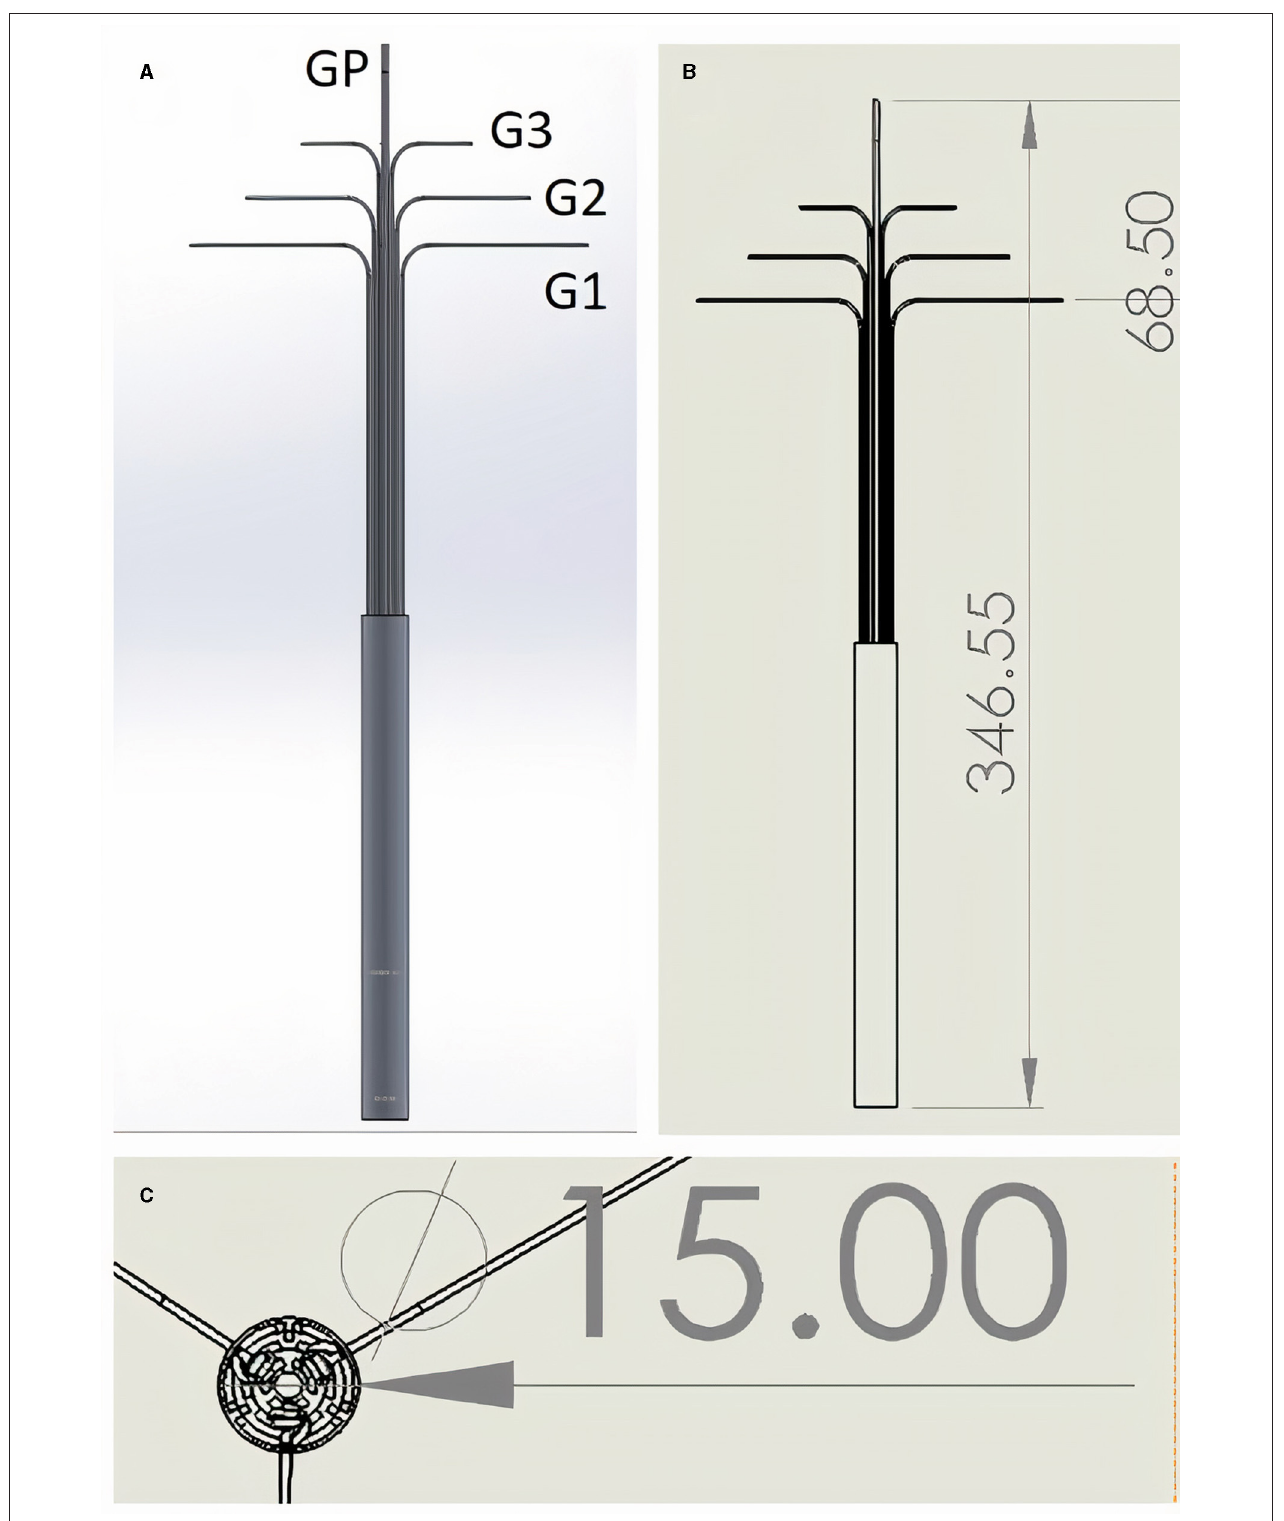
FIGURE 1 | (A,B) Lateral view. One single Grip (GP) controls forward protrusion and backwards retraction of the instrument. Grips G1–G3 are triplicate (only two of each are visible in the 2D lateral view images shown), and control each of the three distal arms to which they are attached (distal arms not visible - infolded and covered by sheath). G3 Grips control the curvature of the patch, G2 the rotation angle of the arm, and G1 the deployment angle of the arm. (C) “Top down” view showing triplicate arrangement of Grips when in line with each other and opened with 120 degree angles between each set of three Grips. Grips exit the cylindrical instrument body which has diameter of 15 mm. All measurements in mm. See Supplementary Video 1 for dynamic demonstration in silico .